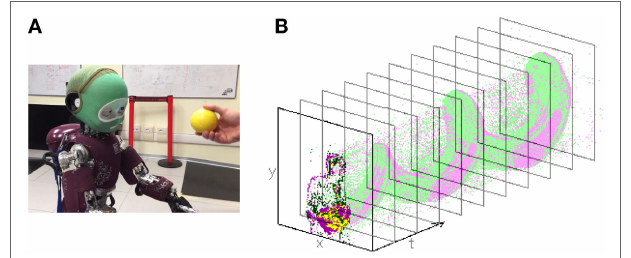
FIGURe 1 | The (A) iCub robot performing ball tracking and gazing toward the ball position and (B) the corresponding stream of events over time superimposed with approximate frame-captures for a hypothetical 10 Hz frame-based camera.